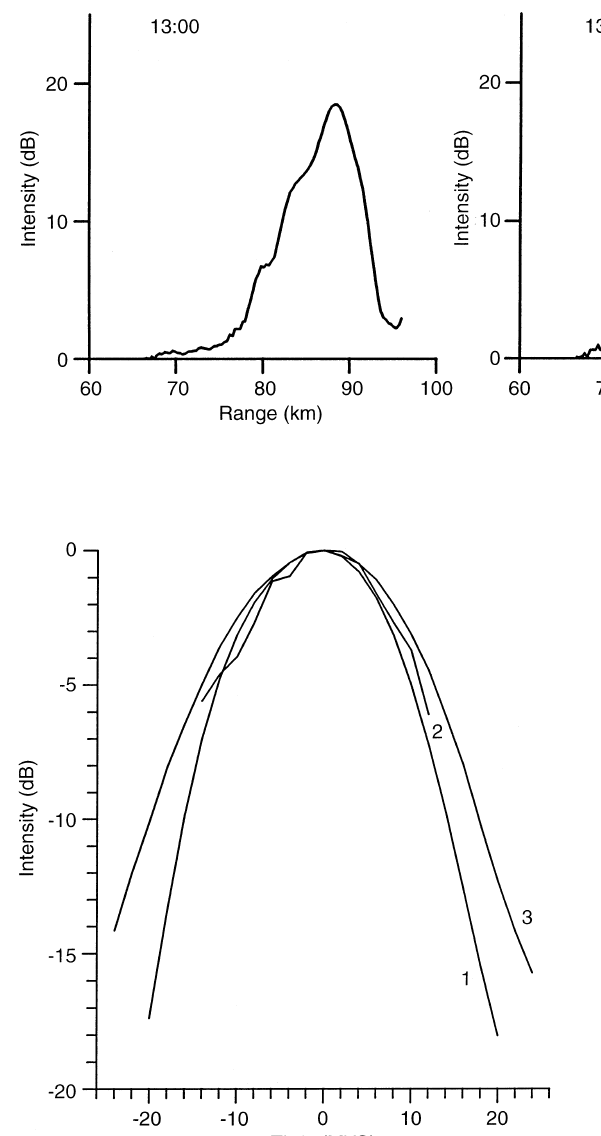
Fig. 3. Profiles of mesospheric echoes, obtained on 25 July 1994, averaged over about 5-min intervals. Two layers in the mesopause region are seen at 11:30 and 13:30, while they are not fully resolved at 13:00. Only one layer was observed at 12:00. Weak layers below 80 km are also clearly seen